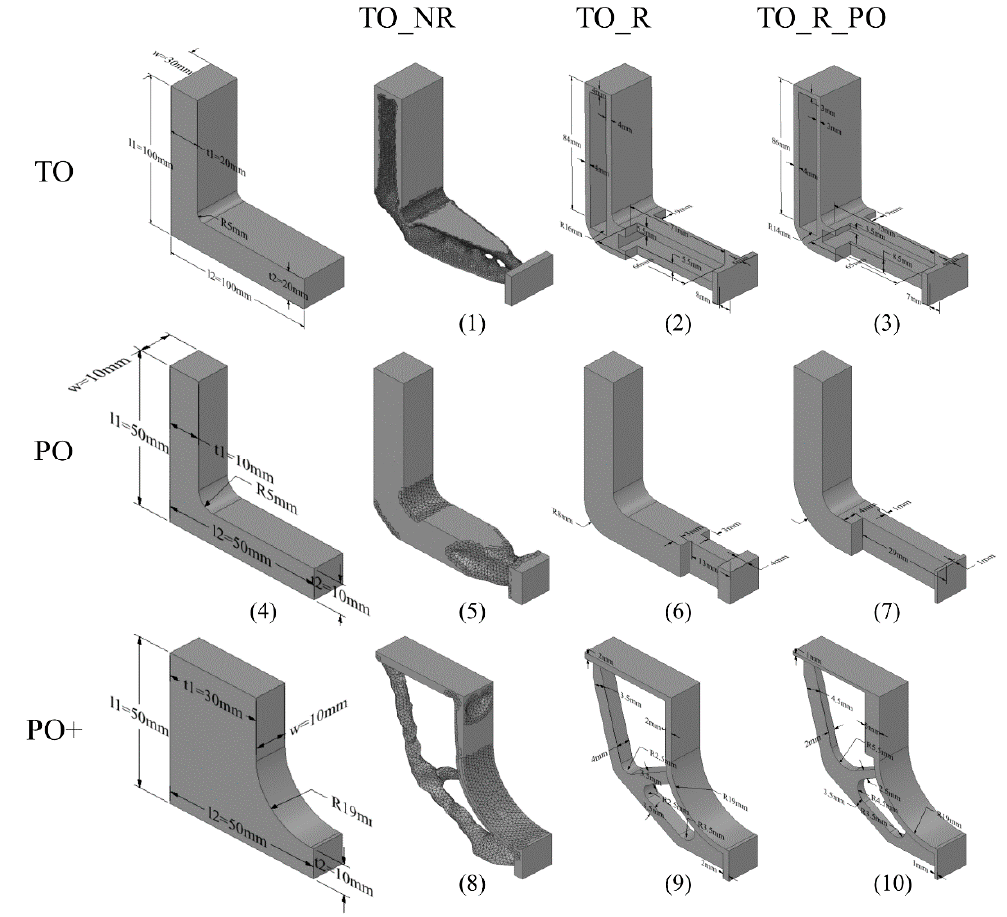
Figure 15. The design solutions of the L ‐ Bracket.